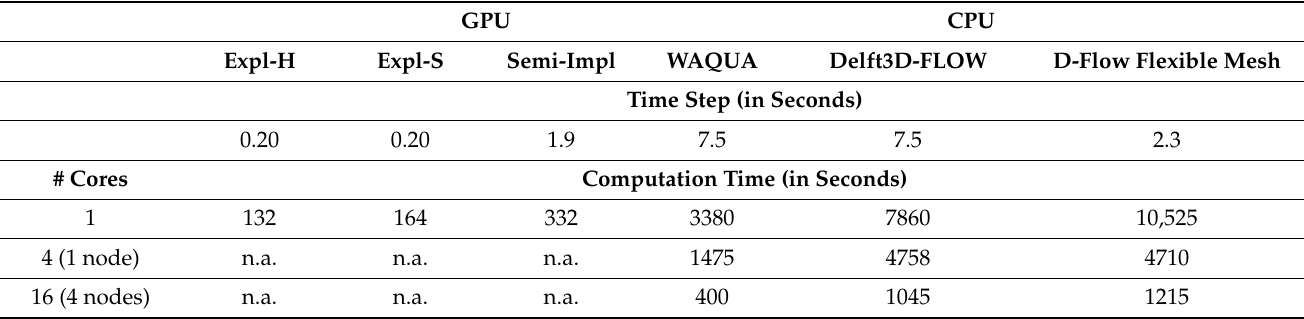
Figure 10. Illustration of currents for the “Semi-impl” method ( left panel ) and currents for WAQUA ( right panel ). Table 3. Computation times (in seconds) and average time step (in seconds) for a simulation period of one day with a 2D river Meuse model (n.a.—not